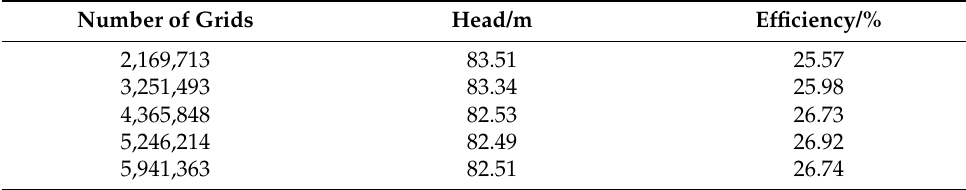
Table 2. Grid independence analysis.